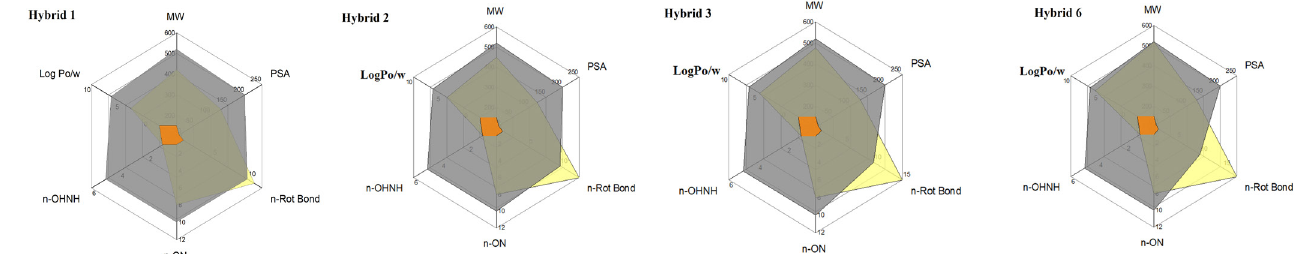
FIGURE 9 - The bioavailability radar plots of the active hybrids 1 - 3 , 6 : the gray area represents the optimal range for 95% of the FDA-approved drugs. The yellow area represents calculated drug-likeness properties of hybrids. The orange zone indicating low oral